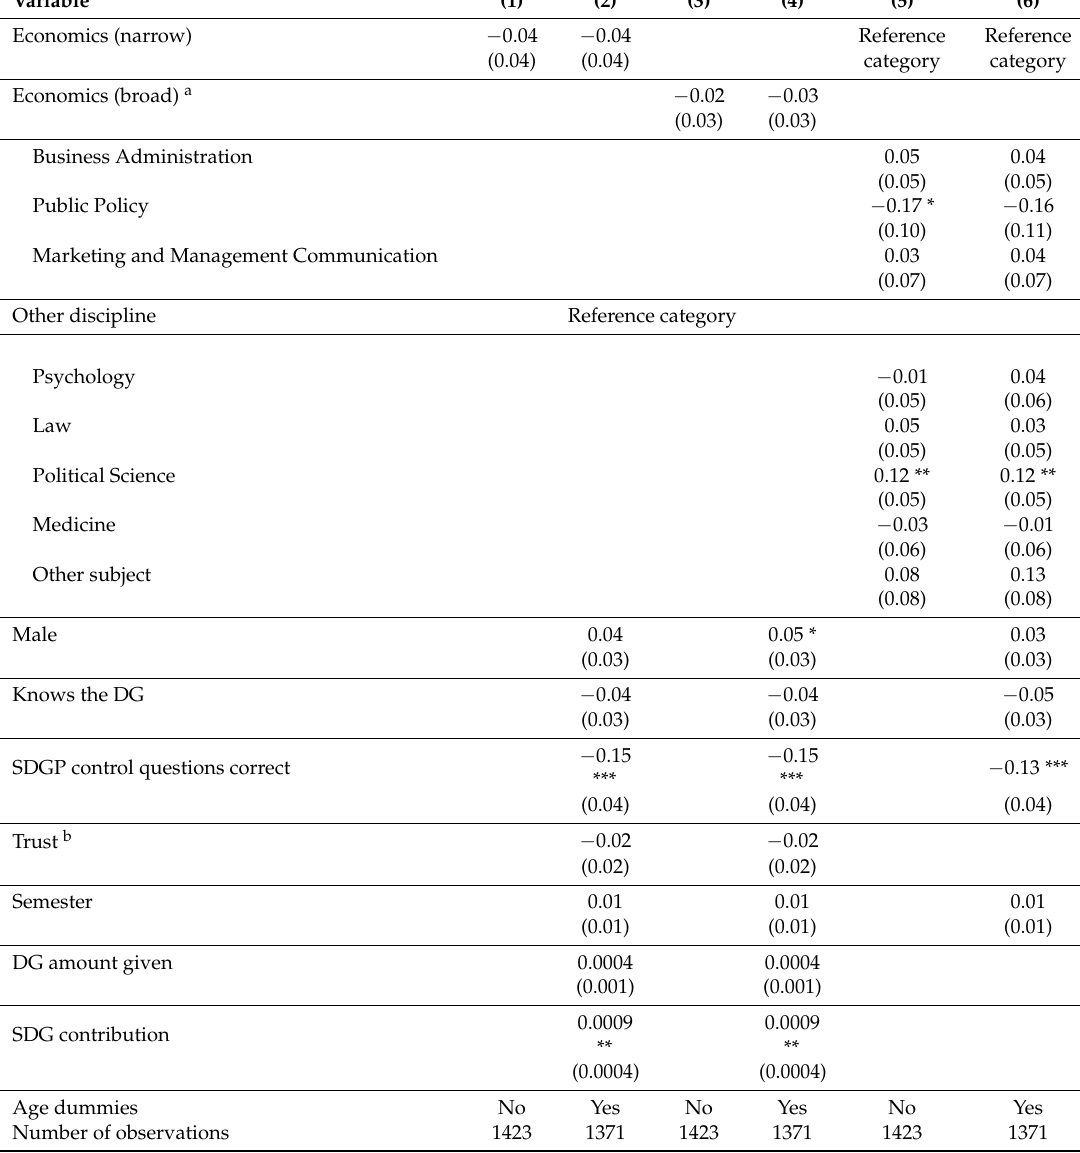
Table 3. Logistic regressions for punishment behavior in the social dilemma game with punishment.